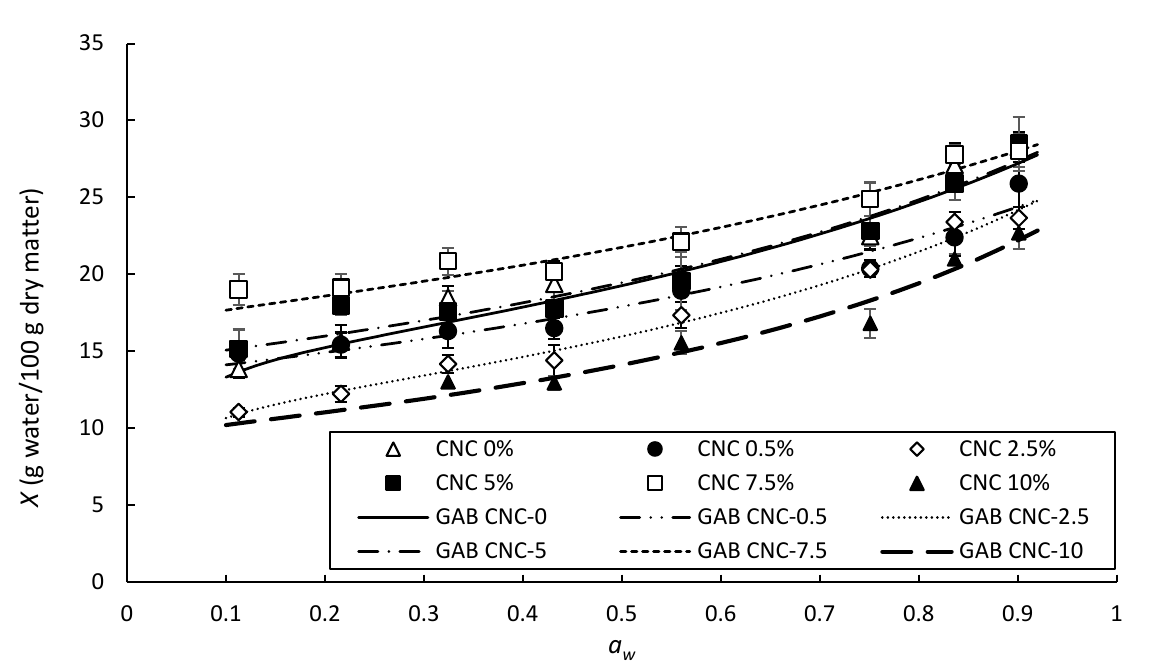
Figure 5. Water adsorption isotherms of starch–chitosan films reinforced with CNC (0, 0.5, 2.5, 5, 7.5, and 10% w / w ) at 25 °C. Experimental data (symbols); fitted to the GAB mathematical model (solid and dotted lines). Table 3. GAB mathematical model parameters and regression coefficient, R 2 , calculated for composite starch–chitosan films with